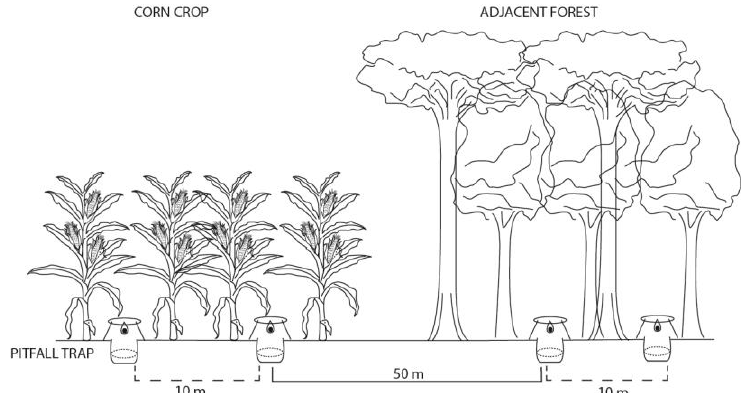
Figure A1. Experimental design scheme used for the captured individuals of C. quinquemaculatus in maize crops and adjacent forests of Atlantic Forest in the region of São Miguel do Oeste, SC, Brazil.